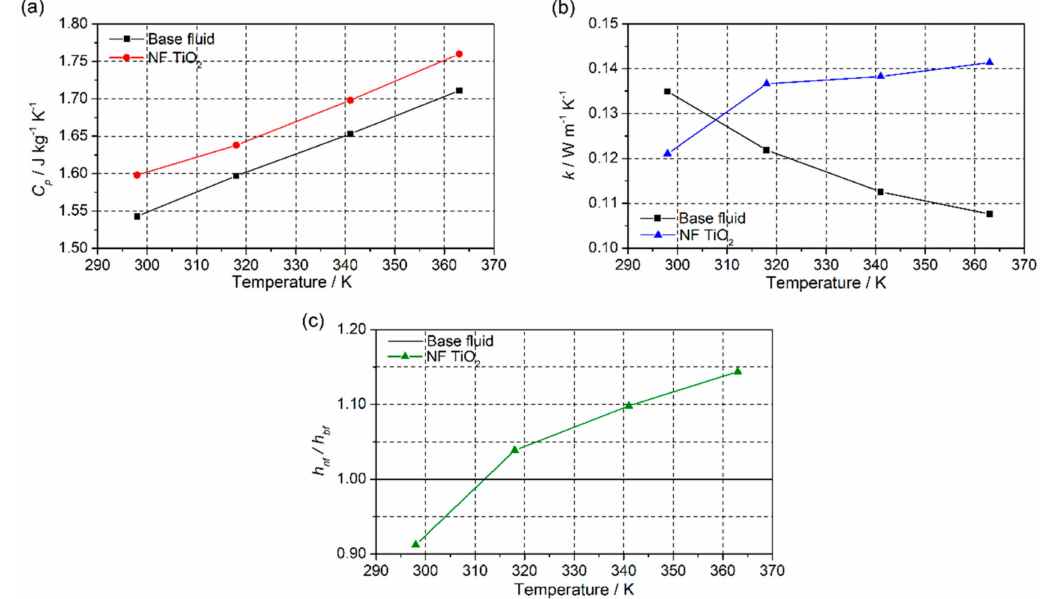
Figure 10. ( a ) Isobaric specific heat, ( b ) thermal conductivity, and ( c ) ratio of the heat transfer coefficient between TiO 2 -nanofluid and the base